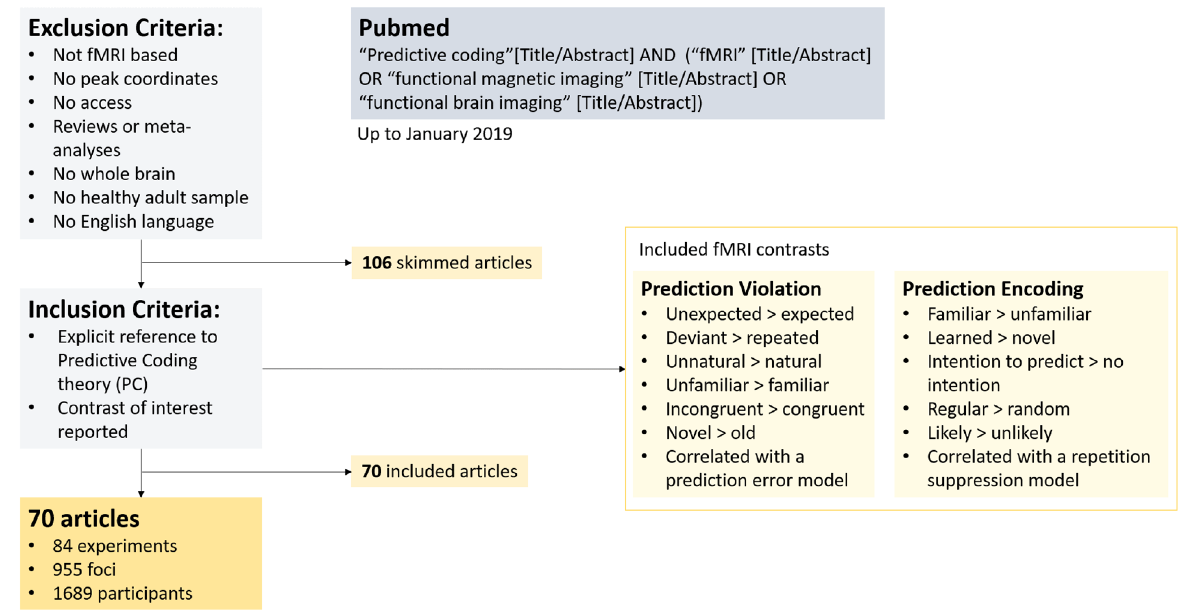
Figure 1. Flowchart representing the process of search and selection of potentially eligible articles for the meta- analysis and the SVC